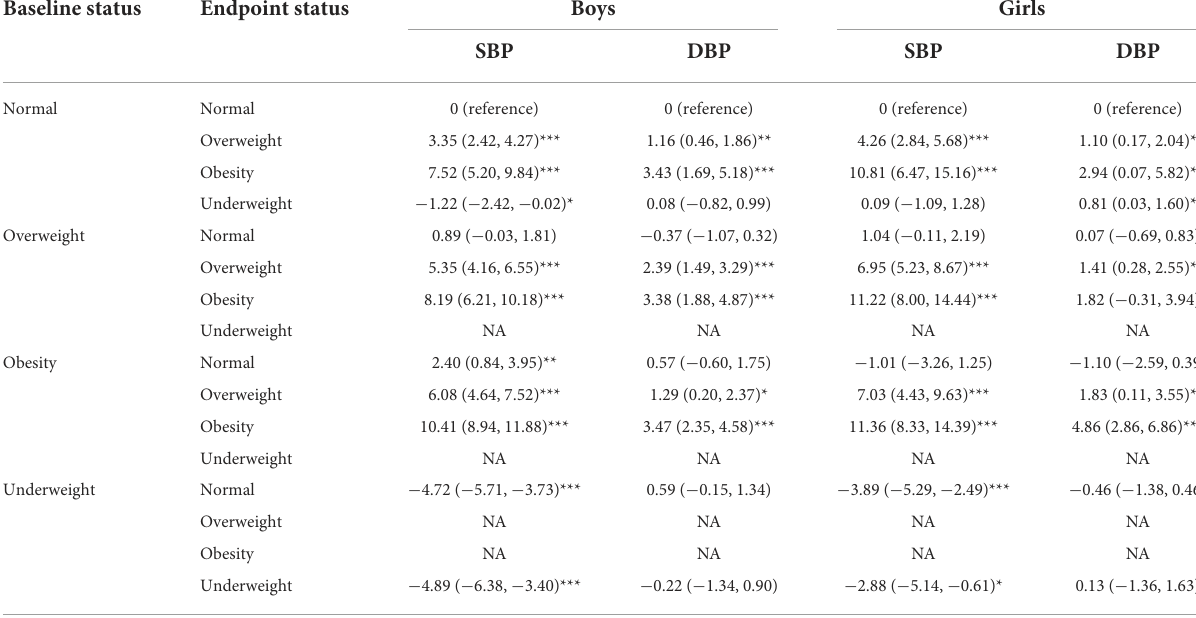
TABLE 3 Difference in blood pressure at late adolescence among children of different weight